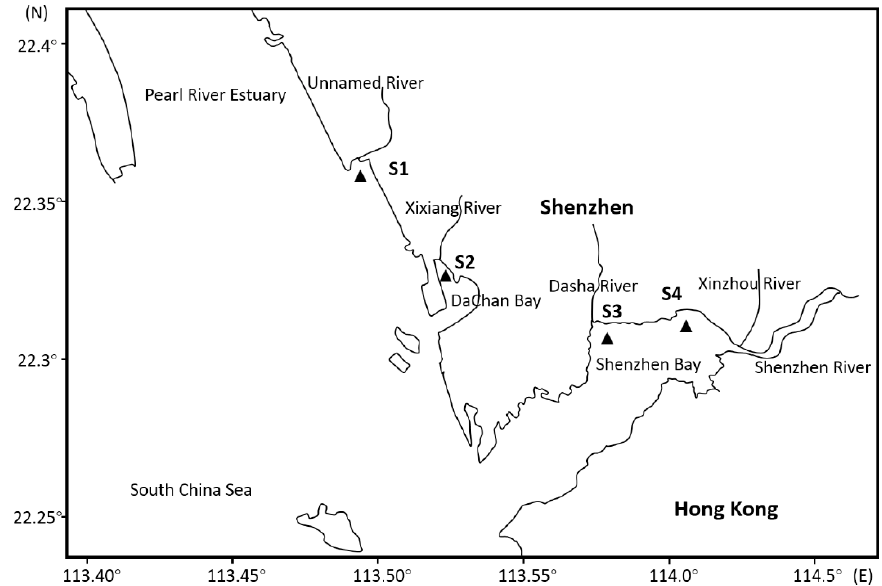
Figure 1. Locations of four sampling stations (S1–S4; black triangles) off the Shenzhen coast in South China Sea.